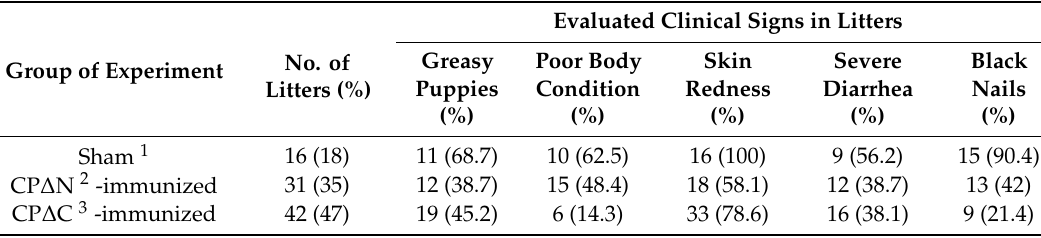
Note: 1 Sham refers to the control group injected with pDual-GC-vector-transfected cell lysate; 2 CP ∆ N refers to an N-terminal truncated protein (spanning aa 161–775 of CP) of MAstV; 3 CP ∆ C refers to a C-terminal truncated protein (spanning aa 1–621 of CP) of